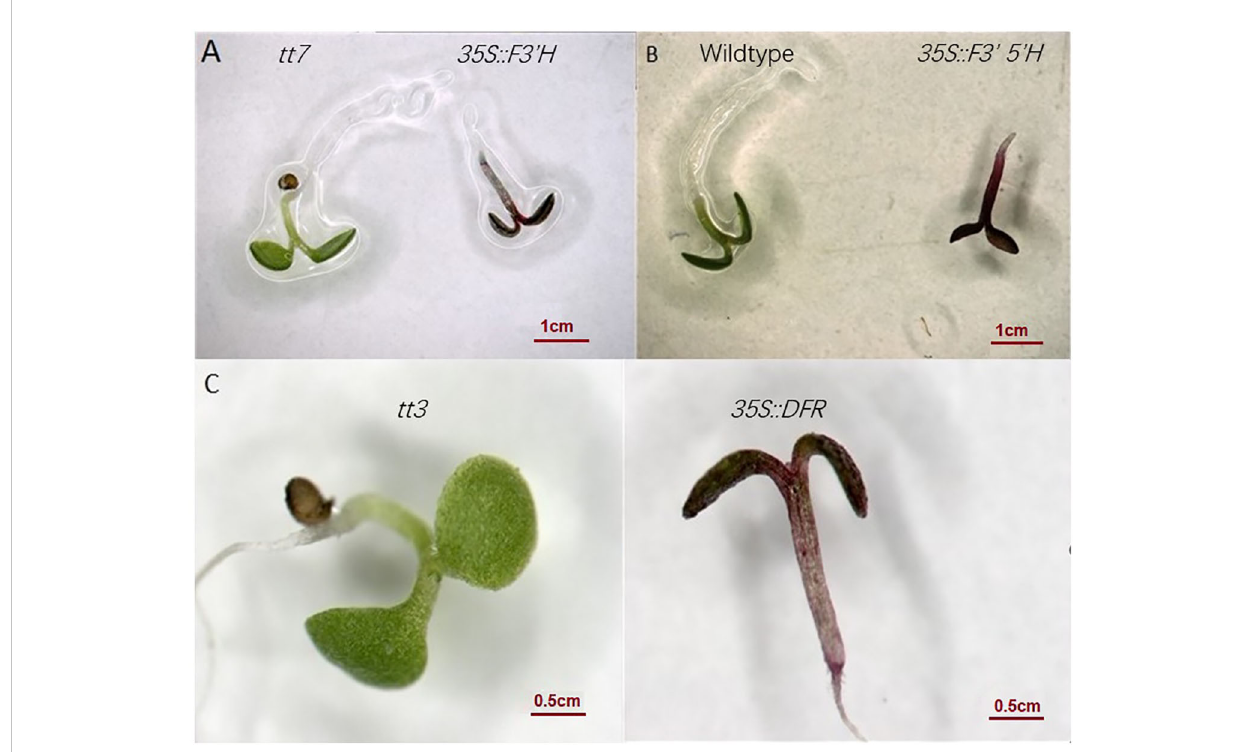
FIGURE 6 Phenotypes of the Arabidopsis with overexpression of EsF3 ’ H , EsDFR and F3 ’ 5 ’ H (A) Image of anthocyanin in tt7 mutant and rescuing line of EsF3 ’ H in tt7 background, (B) Phenotypes of wild-type, and transgenic Arabidopsis seedling with EsF3 ’ 5 ’ H , (C) Phenotypes of tt3 mutant, and transgenic Arabidopsis seedling with EsDFR